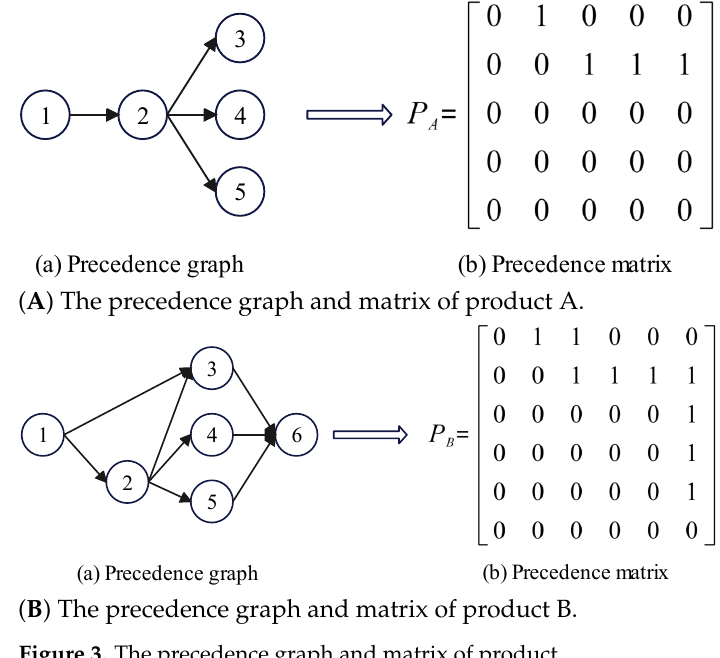
Figure 3. The precedence graph and matrix of